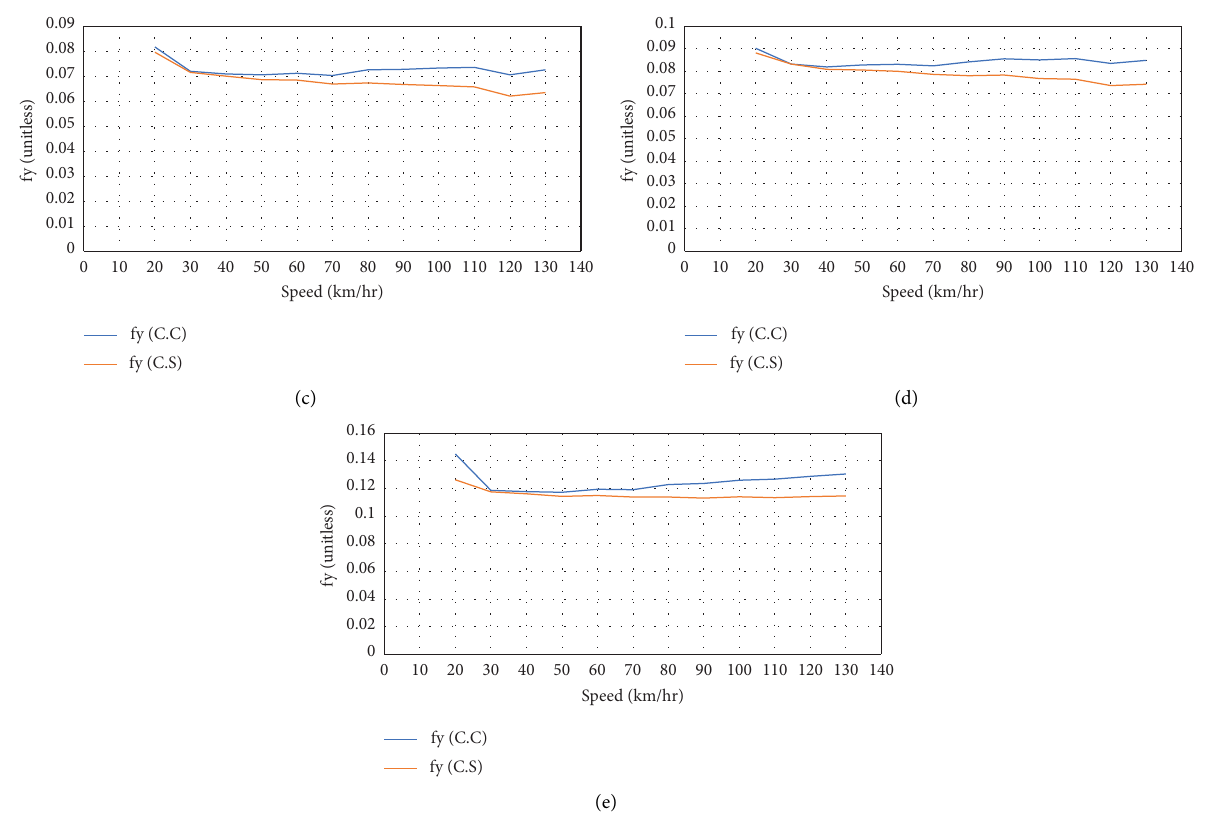
Figure 17: Comparison of the maximum side friction factor for sedan in simple and spiral horizontal curves versus the speed in the radii: (a) 1.3 R, (b) 1.1R, (c) R, (d) 0.9R, and (e) 0.7R.